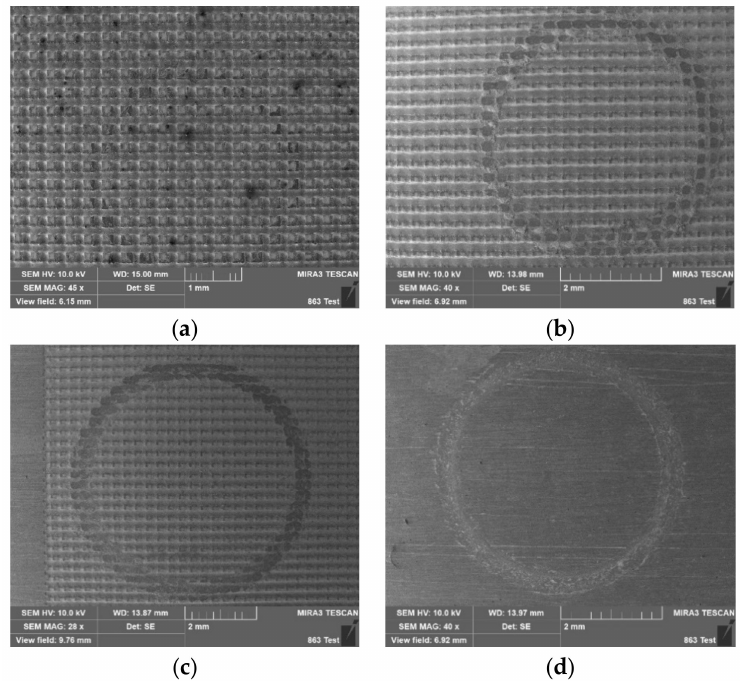
Figure 19. Wear scar morphology of convex-hull textured pruner at di ff erent loads: ( a ) wear scar at the load of 300 g; ( b ) wear scar at the load of 1100 g; ( c ) wear scar at the load of 2000 g; ( d ) wear scar of non-textured pruner at the load of 2000